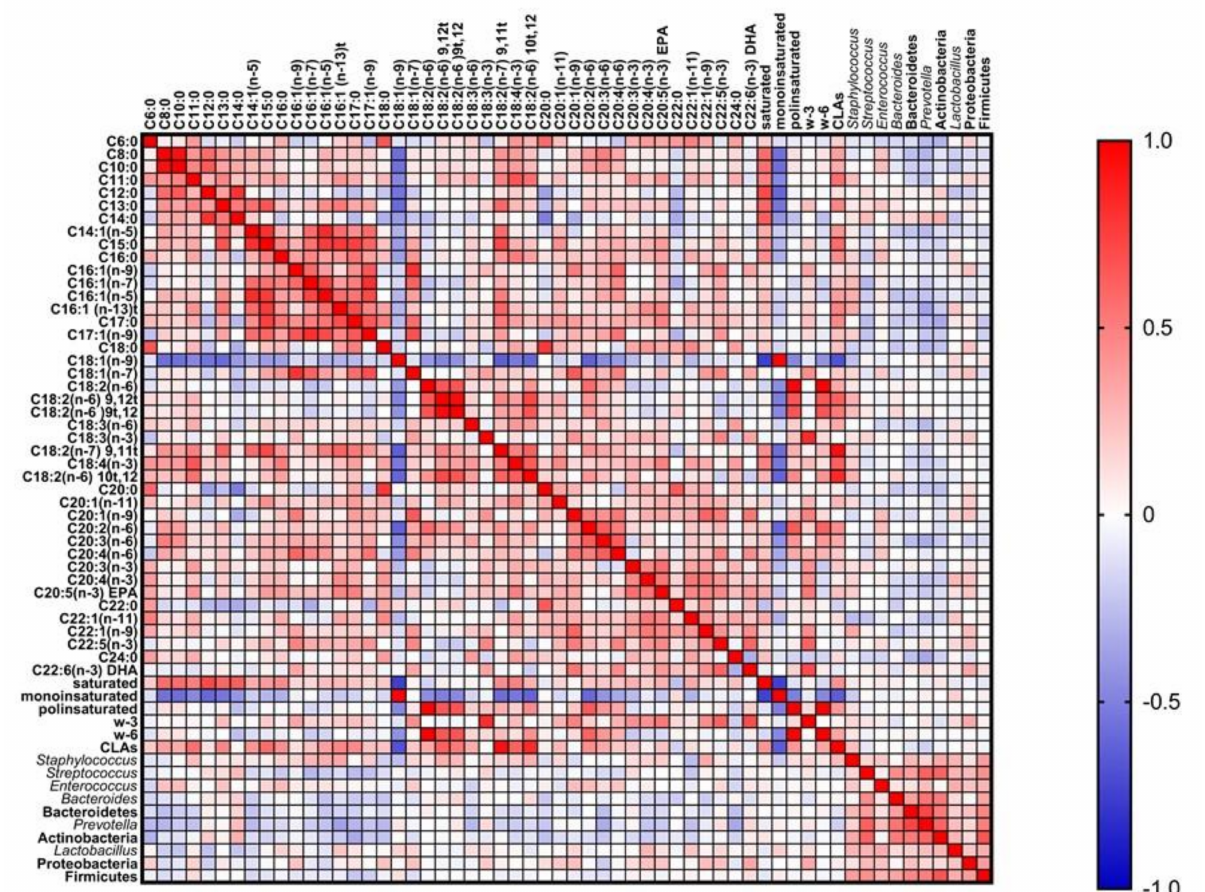
Figure 5. Graphical Spearman correlation matrix showing pairwise correlations between breast milk fatty acids and microbiota groups in healthy Spanish mothers; colours are added for better visualization of correlation r